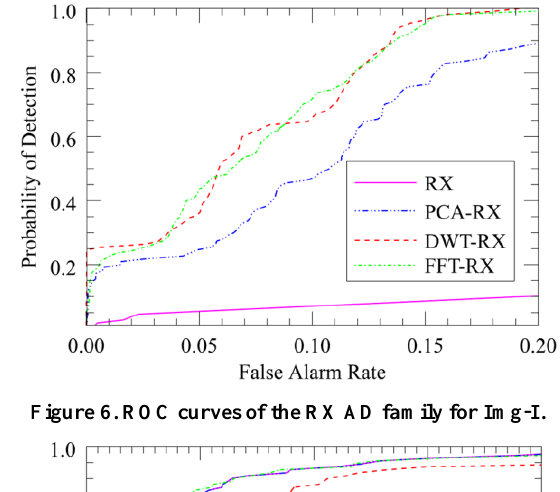
Figure 6. ROC curves of the RX AD family for Img-I.